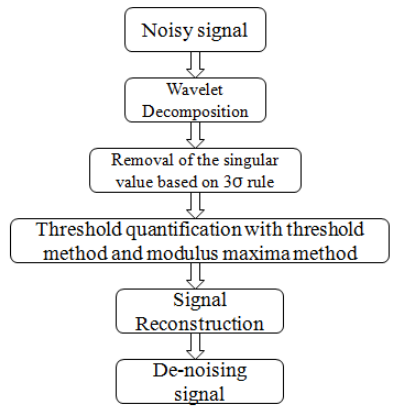
Figure. 3 Flow of de-noising process